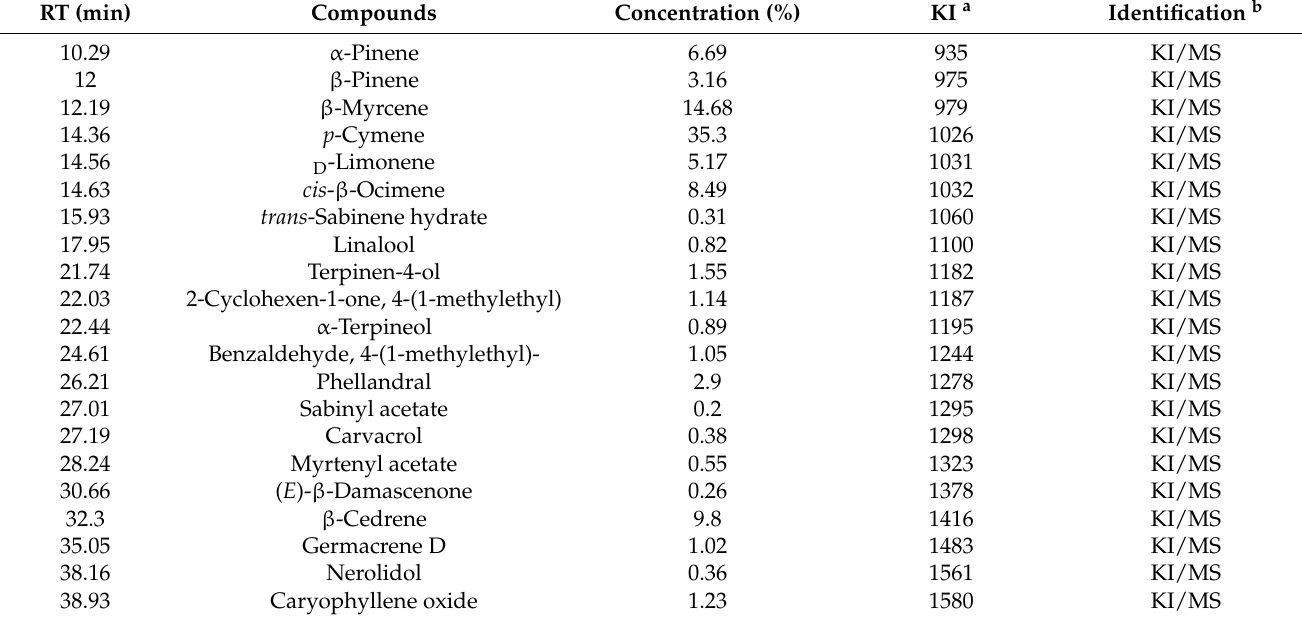
Figure 4. Effect of GTEO on LPS-induced I- κ B α instability followed by activation of IKK α . RAW 264.7 cells were stimulated with LPS (1 μ g/mL) and incubated in the presence or absence of increasing concentrations of GTEO (25–200 µ g/mL) for 1 h. The phosphorylated and total levels of I- κ B α and IKK α were determined by immunoblotting with specific antibodies. GAPDH served as an internal loading control. Histogram shows the relative protein expression levels of iNOS and COX-2, which are normalized with an internal control GAPDH. Data are reported as mean ± SD of three independent experiments. ∆ p < 0.001 indicates a significant difference between the control and LPS-only treated groups. ** p < 0.01, and *** p < 0.001 show significant differences between the LPS-alone and GTEO treatment groups. Table 1. The major components and their relative contents (%) of G. tenuifolia essential